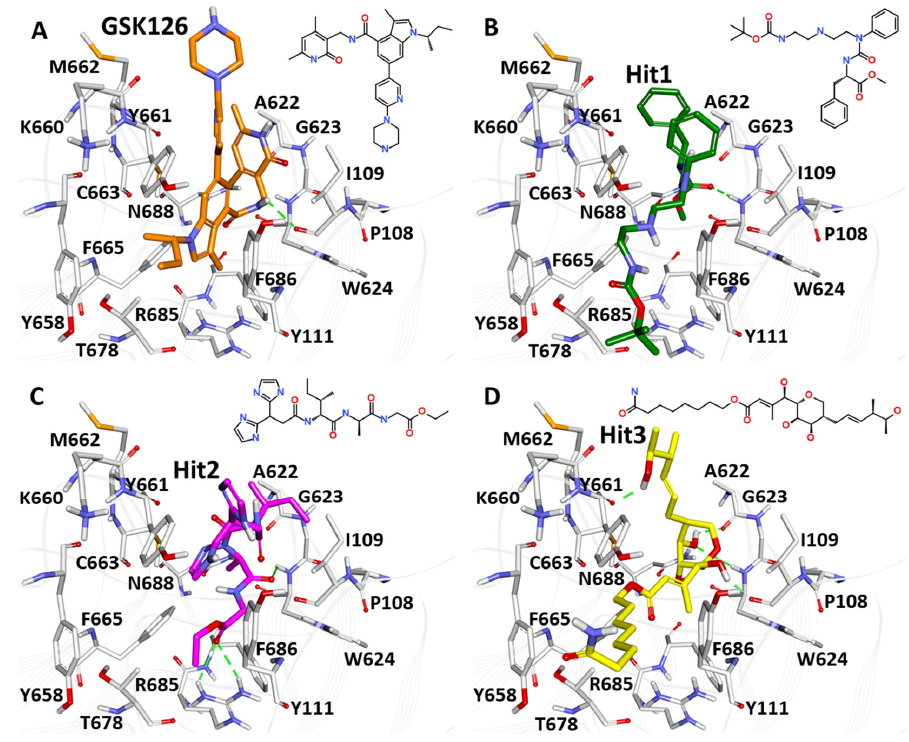
Figure 9. Binding analysis of top hits from molecular docking: ( A ) Reference compound (GSK126), ( B ) Hit1 (NCI694864), ( C ) Hit2 (NCI670557) and ( D ) Hit3 (NCI706726). The active site residues are shown in grey sticks. The protein backbone is shown in light grey wire. Hydrogen bonds were illustrated with green dashed line.